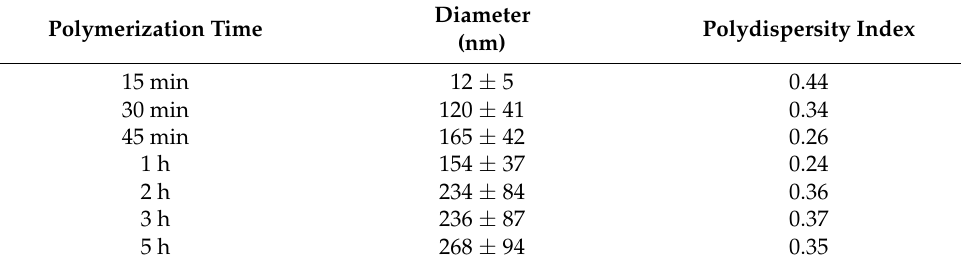
Table 1. Dynamic light scattering results for ciprofloxacin-imprinted nanoMIPs.